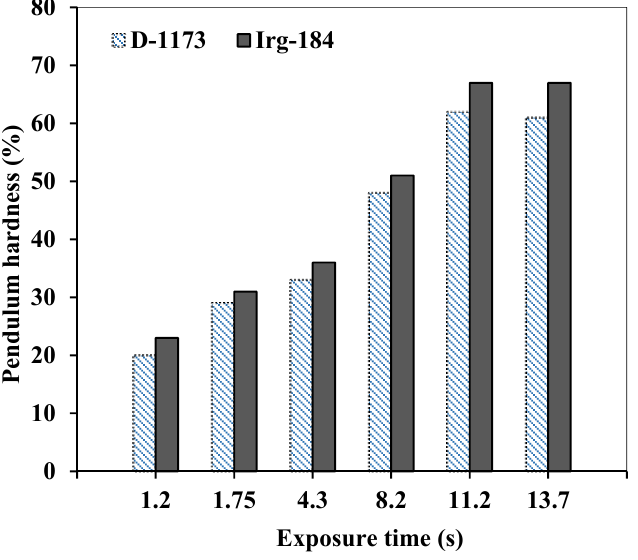
Figure 10. Pendulum Hardness Percentages of the UV cured EPOLA Films with D-1173 and Irg-184 Photoinitiators.